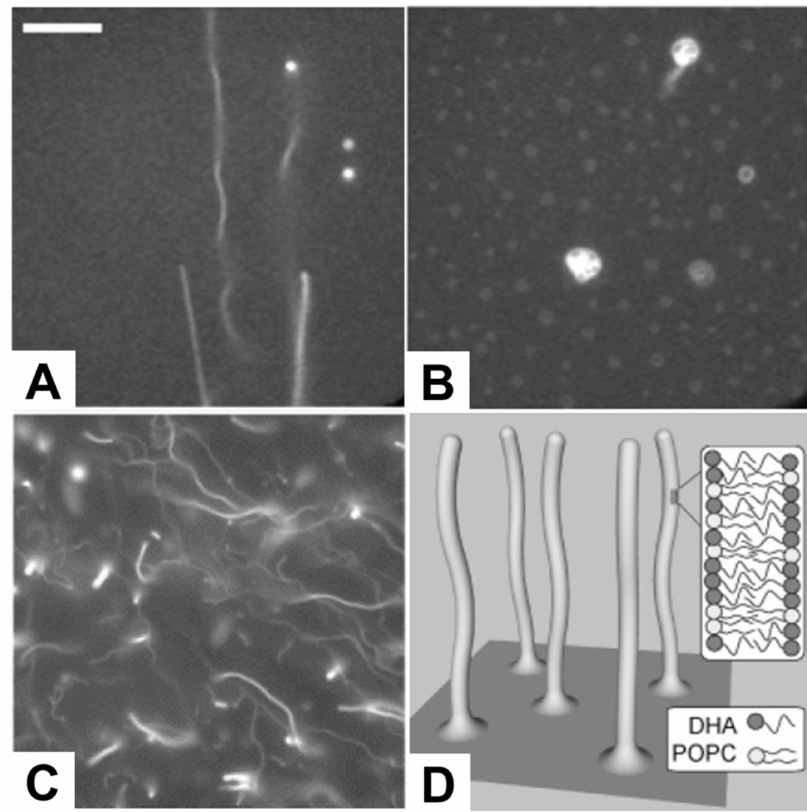
Figure 6. Fluorescence micrographs depicting the morphological responses of SLBs. The morphological responses occurred after treatment with 50 µ M lysophosphatidylcholine (LPC) in ( A ) 250 mM KCl and ( B ) 50 mM KCl, and ( C ) 200 µ M docosahexaenoic acid (DHA) and corresponding ( D ) proposed mechanism of tubule formation. The scale bar in part A is 25 µ m, and is valid for images in parts A and B. The image in part C is 80 µ m × 80 µ m. Reproduced with permission from [128] (Copyright 2008, American Chemical Society) and [43] (Copyright 2007, American Chemical